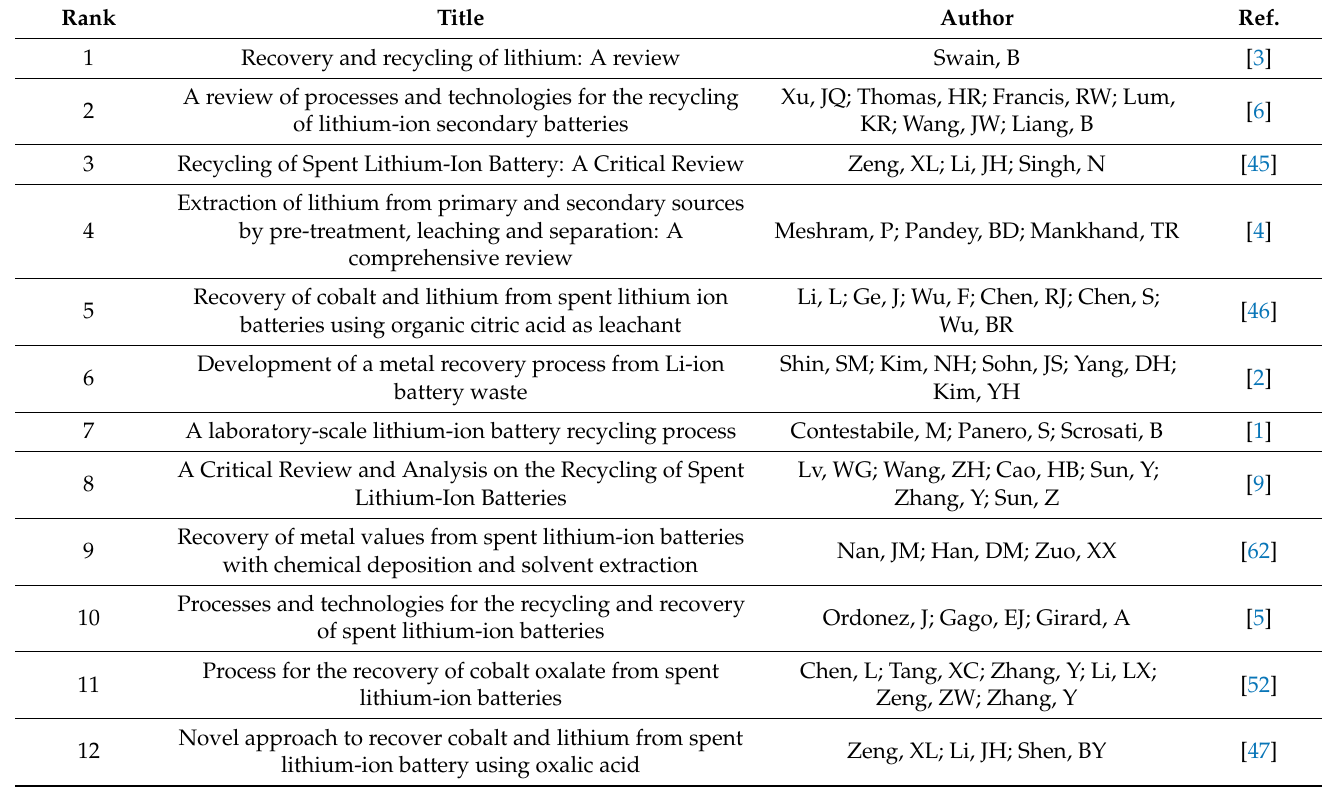
Table 5. List of the highest-ranking articles based on the ProKnow-C